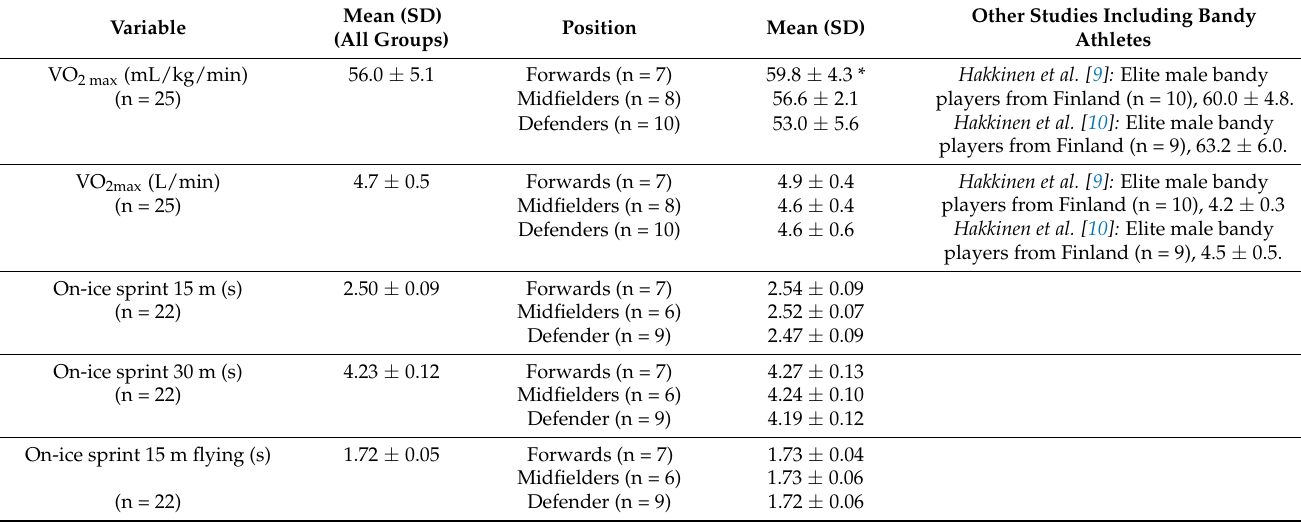
Table 3. Endurance and sprint characteristics of the